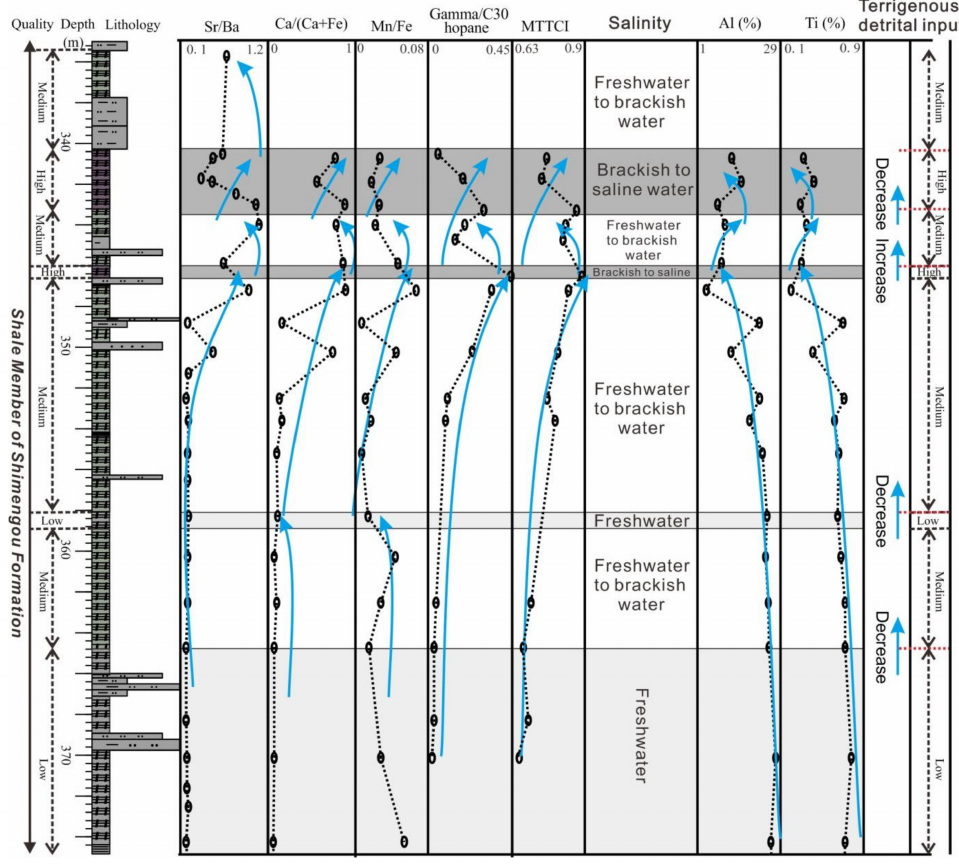
Figure 6. Vertical distribution of salinity and terrigenous detrital input in different-quality oil shales in the Shale Member of the Shimengou Formation (See Figure 2 for a legend; Gamma/C30 hopane = Gammacerane/C 30 αβ